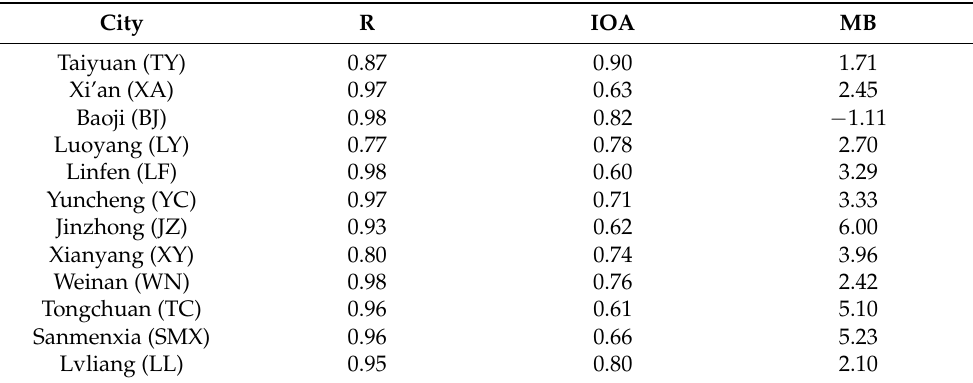
Figure 2. The observed and predicted temperature at 2 m. Table 3. Assessment parameters for temperature